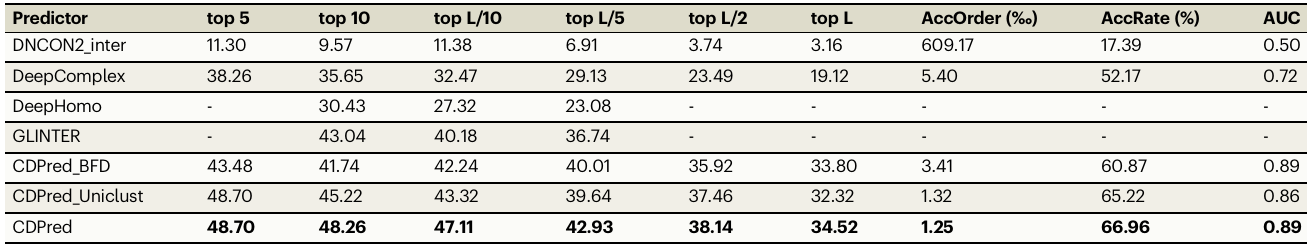
Table 2 | The precision of top 5, top 10, top L/10, top L/5, and top L contact predictions, accuracy order, accuracy rate, and AUC score on the HomoTest2 test dataset for DeepHomo, GLINTER, and CDPred predictors Predictor top 5